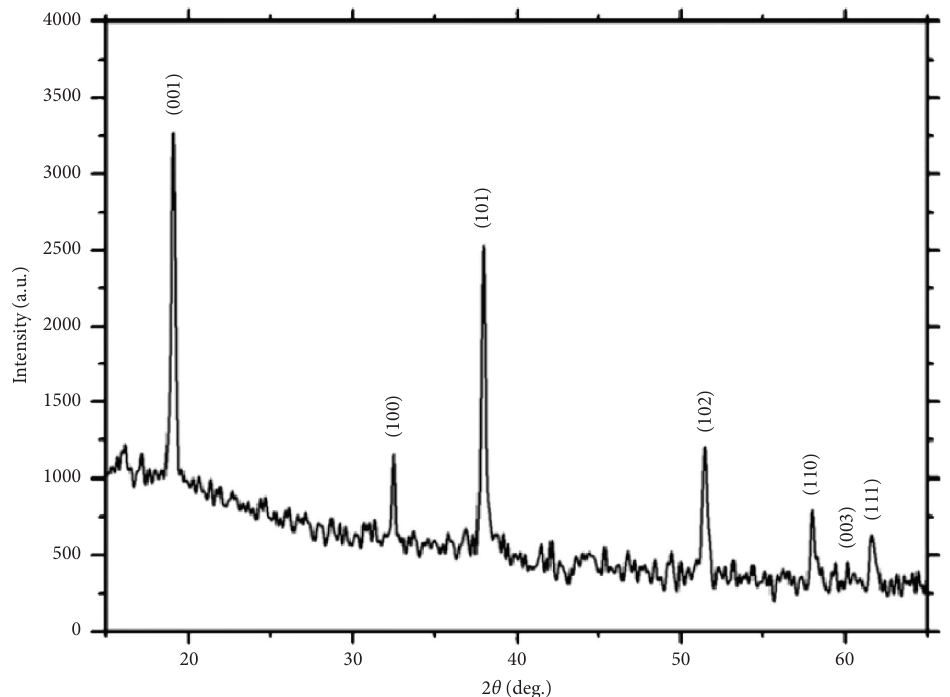
Figure 5: XRD pattern of electrodeposited cobalt hydroxide thin flm sample